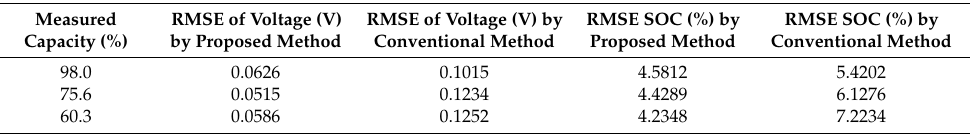
Table 1. Comparison of proposed and conventional method.